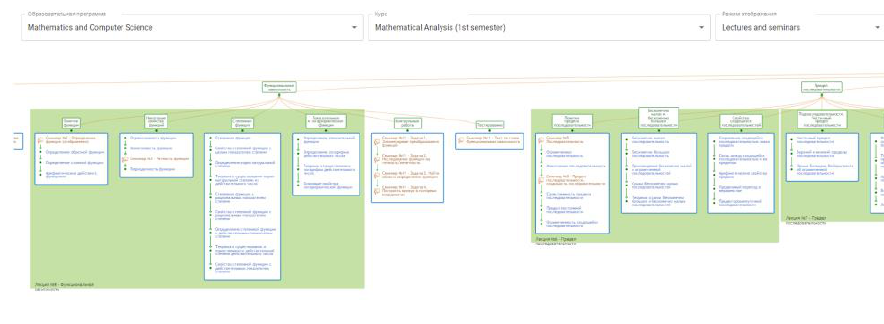
Fig. 4. The structure of the course "Mathematical analysis" for mathematical specialties The tasks in the system are assumed to be typical, i.e. there are not separate tasks, but types of tasks: Seminar (problem solving algorithm and analyzed examples of problem solving), Independent work (IW), which the student performs either in the classroom or at home, Homework (HW), for which points are assigned in accordance with the point-rating system adopted at the university, Tests, available to students only during tests, and for which, similar to the type of HW, points are put down in accordance with the point-rating